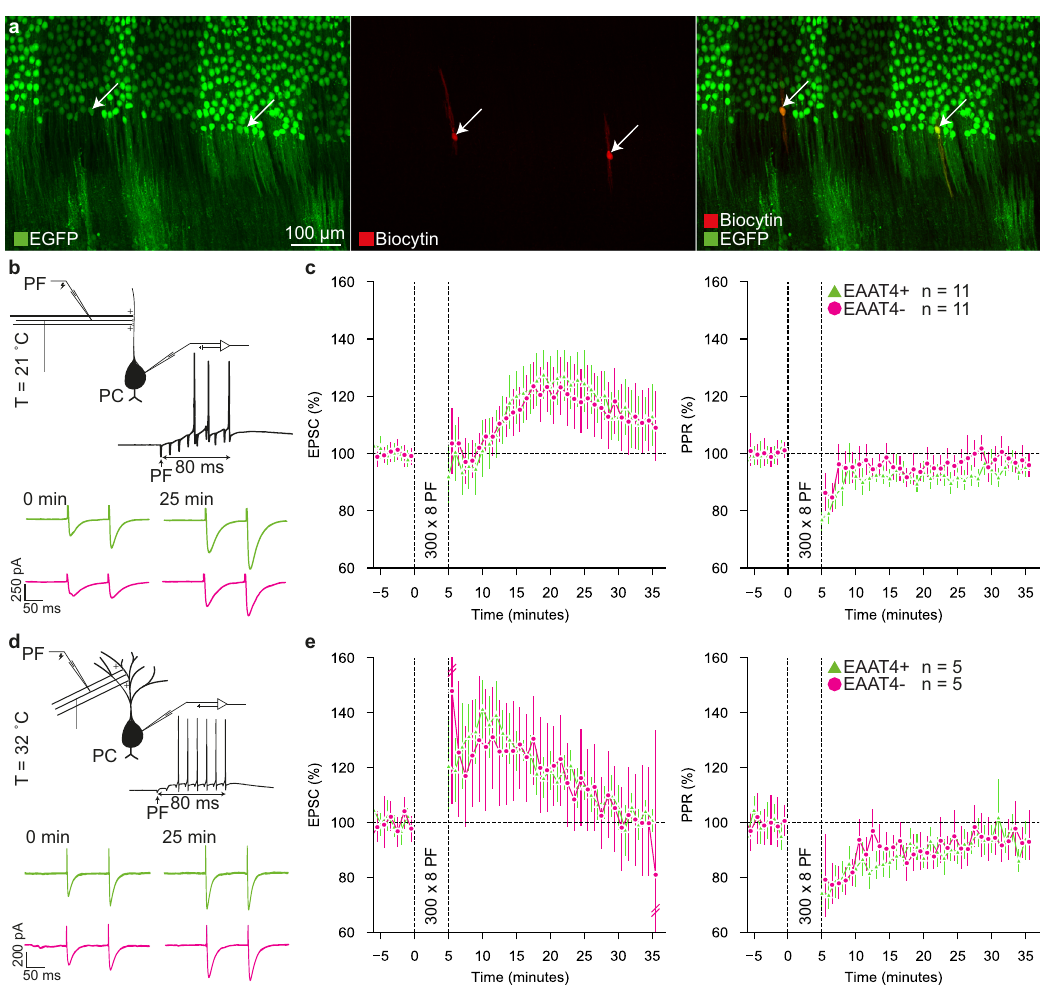
Fig. 2 Presynaptic LTP is not different between EAAT4 + and EAAT4- PCs. a Example confocal images of a coronal slice with two patched PCs (middle, right), one PC is EAAT4 + and the other EAAT4-. b Schematic representation of LTP induction (top), and example traces of EPSCs before and 25 minutes after LTP induction. c Time-course of the EPSC amplitude over time (left). EPSC amplitude was similar after in LTP induction for both EAAT4 + and EAAT4- PCs (both n = 11). Additionally, we observed no differences in the PPR (right) over the course of the experiment. Error bars represent 95% CI. Values were normalized to the mean before LTP induction. d , e Same as in b-c, but in sagittal slices at physiological temperature. At physiological temperature, neither the LTP-induced EPSC amplitude nor PPR differs between EAAT4 + and EAAT4- PCs (both n = 5). Independent samples t-test was used to determine differences for all statistical data presented in panels c and e (Suppl. Table